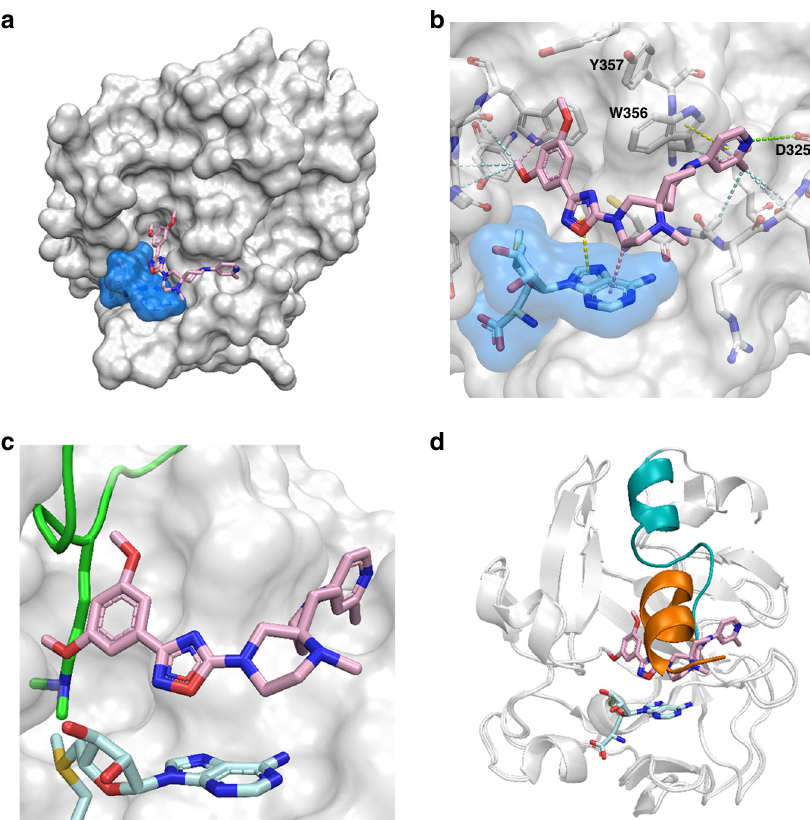
Fig. 3 Co-crystal structure of MRK-740 bound to PRDM9. a Surface representation of PRDM9 PR domain (white) bound by SAM (blue) and MRK-740. b Intermolecular interactions between MRK-740 and its binding pocket. Hydrophobic interactions (light blue), pi – pi interactions (yellow), CH – pi interactions (pink) and polar interactions (green) are represented by dashes. Structural alignment with the mouse holoenzyme (PDB accession code 4C1Q) showing steric clashes between MRK-740 and ( c ) the substrate lysine residue (green) and ( d ) the post-SET substrate recognition helix when in an active, substrate-bound conformation (orange). The corresponding helix in the inhibited, human structure is shown in